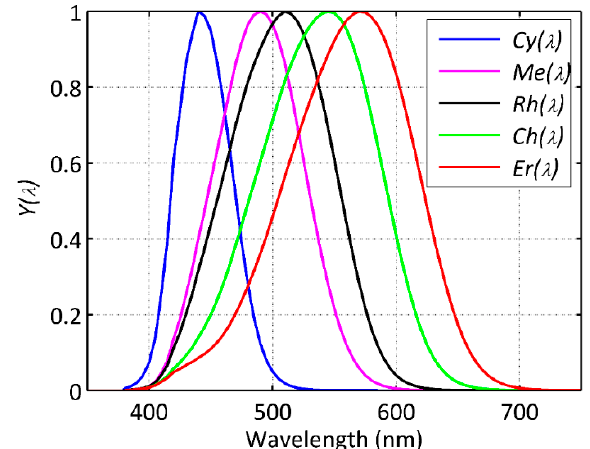
Figure 1. Human photoreceptor spectral sensitivity functions Cy ( λ ) , Me ( λ ) , Rh ( λ ) , Ch ( λ ) , and Er ( λ ) , with SI compliant normalization [17].